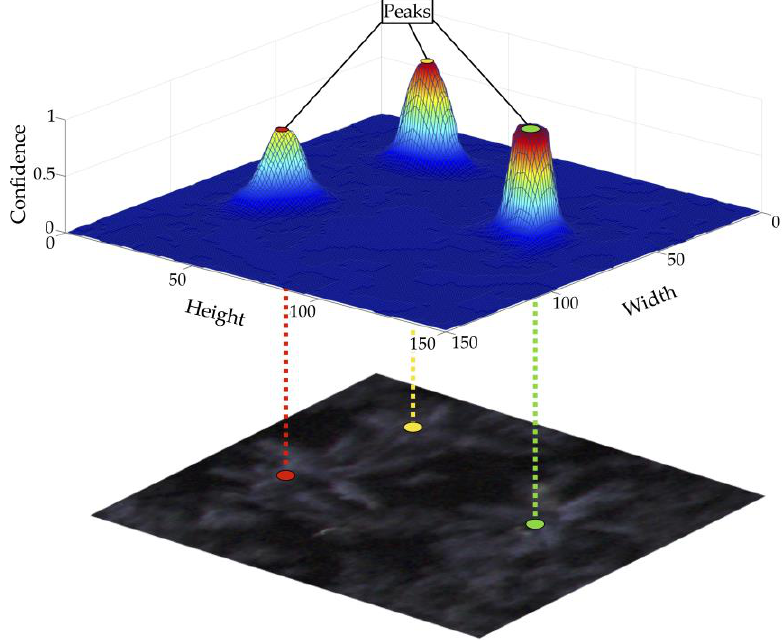
Figure 4. Example of the tree localization from a refined confidence map.